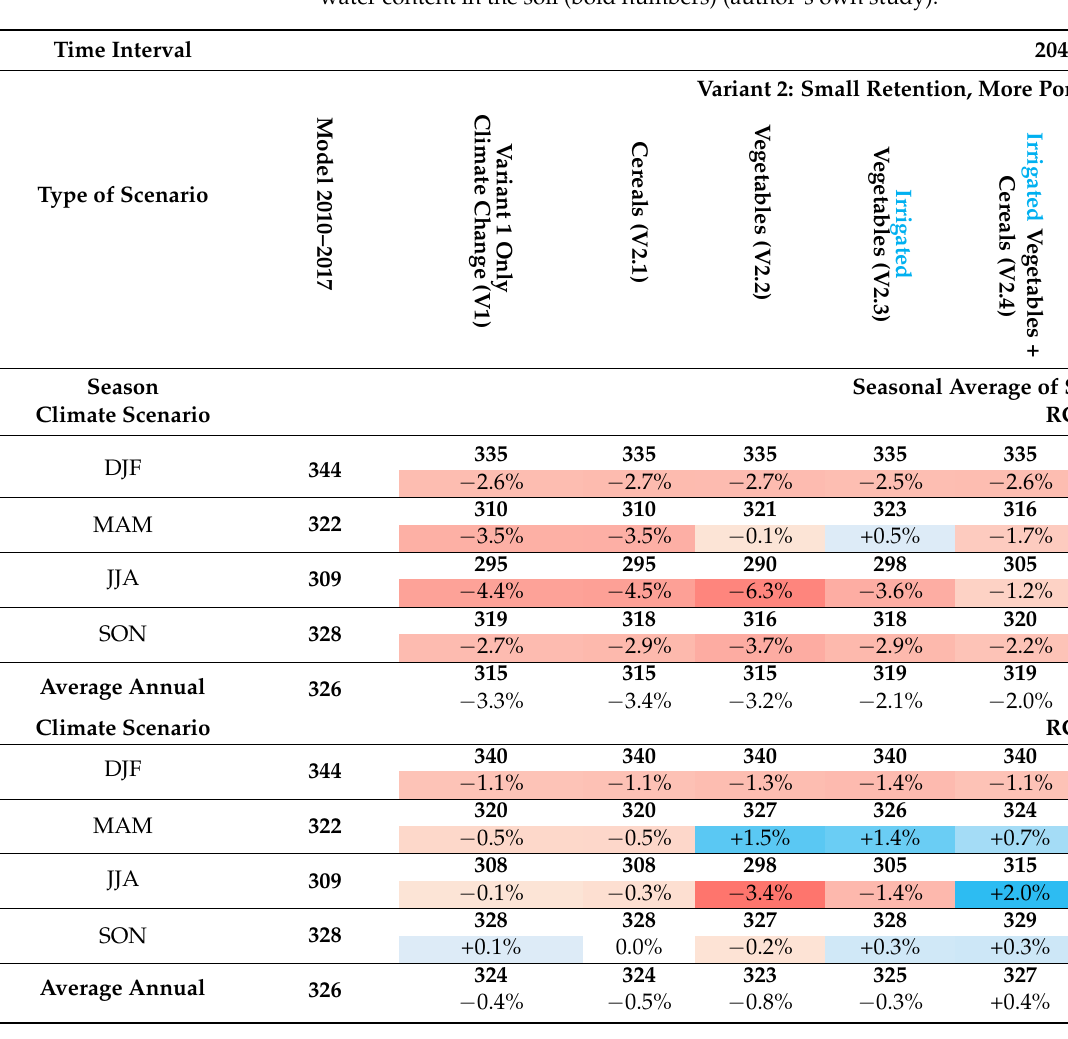
Table 4. Average soil water content in the Bystra catchment for DJF (December, January, February, etc.), MAM, JJA and SON in 2041–2050 under various scenarios (SWAT model, V1, V2.1-V2.5 and V3.1-V3.5) for climate scenarios RCP 4.5 and RCP 8.5. Numbers in red (decrease) or blue (increase) refer to a percentage change in water content in the soil (bold numbers) (author’s own